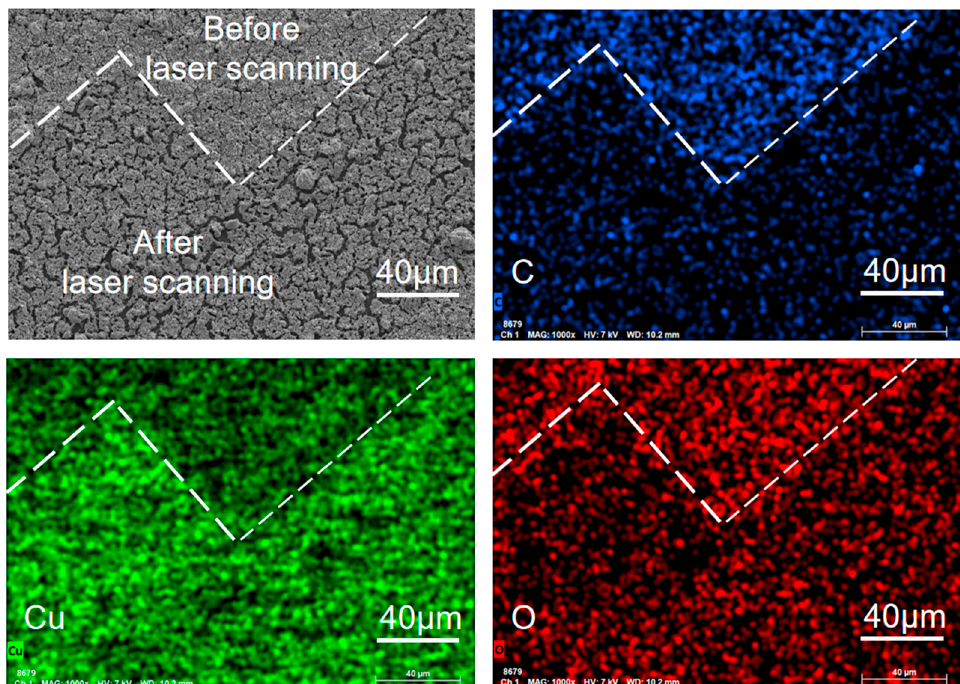
Figure 5. EDS image of the nano CuO ink surface after laser irradiation.